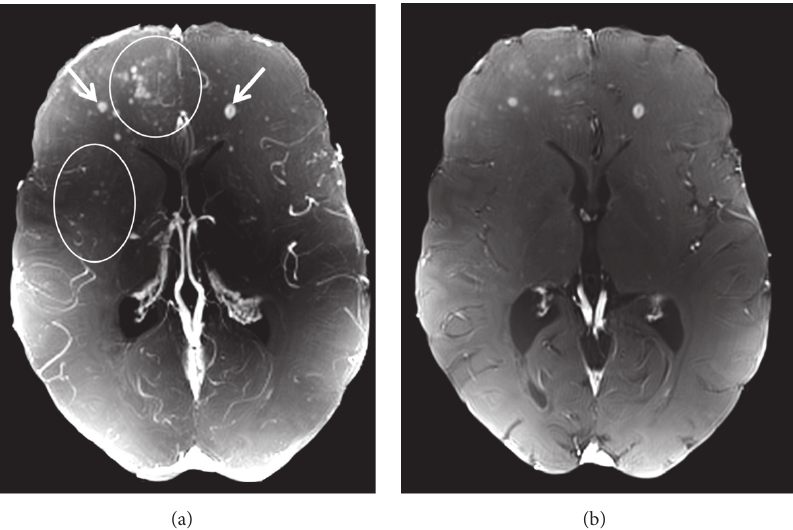
Figure 5: Patterns of Gadolinium enhancement on 7T VIBE images. A maximum intensity projection map of a 7 T T1 weighted Gadolinium enhanced volumetric interpolated brain examination ((a), VIBE) and an exemplary VIBE image (b) are displayed. PML-suspicious punctate Gadolinium enhancing lesions are clearly visible (circles). Ring-enhancing lesions (e.g., arrows) suggestive of MS lesions are